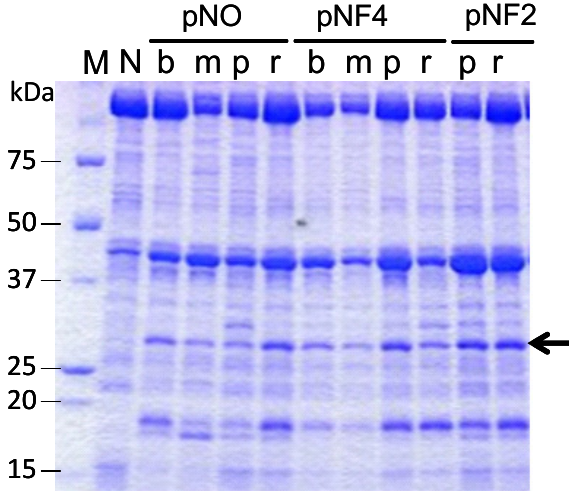
Figure 5. Expression of the scFvFLU protein. Cells were grown in 3 mL of culture medium at 30 °C for two days. N, negative control with blank vector; b, BbrPI signal; m, MWP signal; p, P22 signal; r, R2L6 signal. To compare the productivity of each clone with different signal or different promoter, the same amount, 4 µL/lane, of each